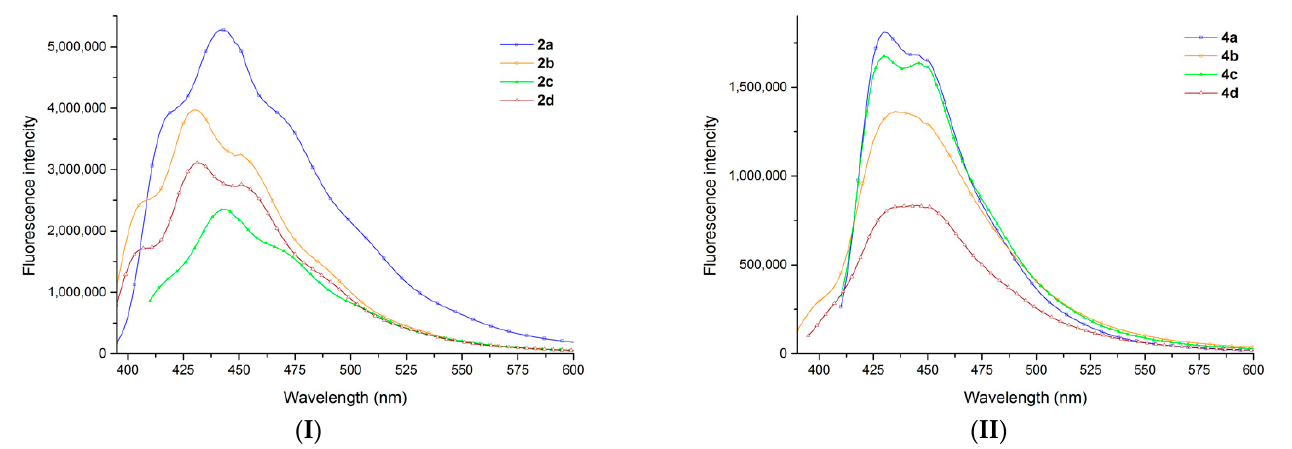
Figure 2. The emission spectra recorded in chloroform solution of the functionalized derivatives: bromides 2a – d ( I ) and azides 4a – d ( II ). Excitation wavelength was: 380 nm for sample 4b ; 385 nm for samples 2a , 2b , 2d , and 4d ; and 400 nm for samples 2c , 4a , and 4c .